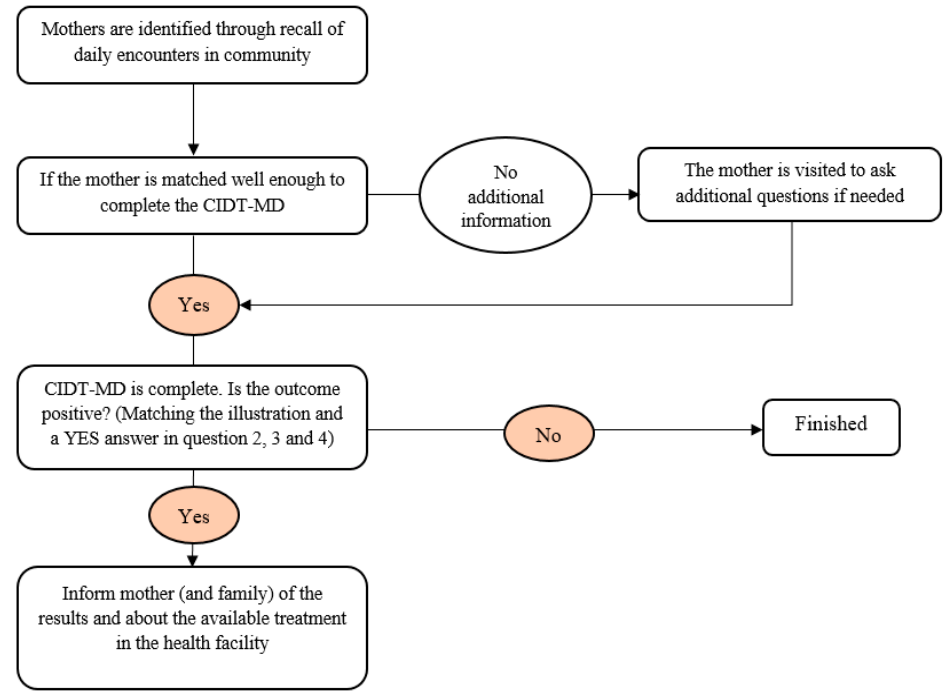
Figure 1. Summary of Detection of Mothers by Community Informants. CIDT-MD is Community Informant Detection Tool for Maternal Depression.